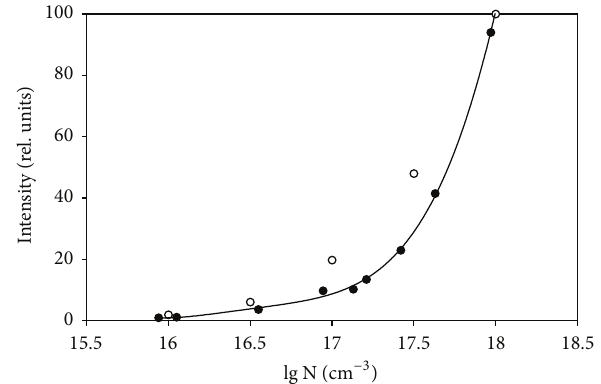
Figure 5: Scheme of electronic terms and transitions of the CO +